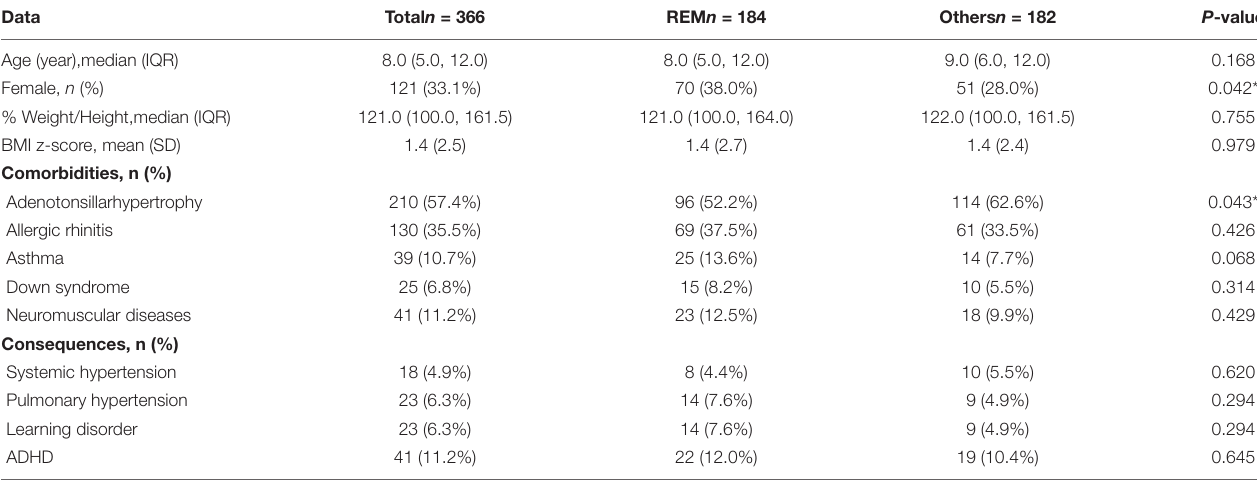
TABLE 3 | Demographic data of children with REM-related OSA and other subtypes.